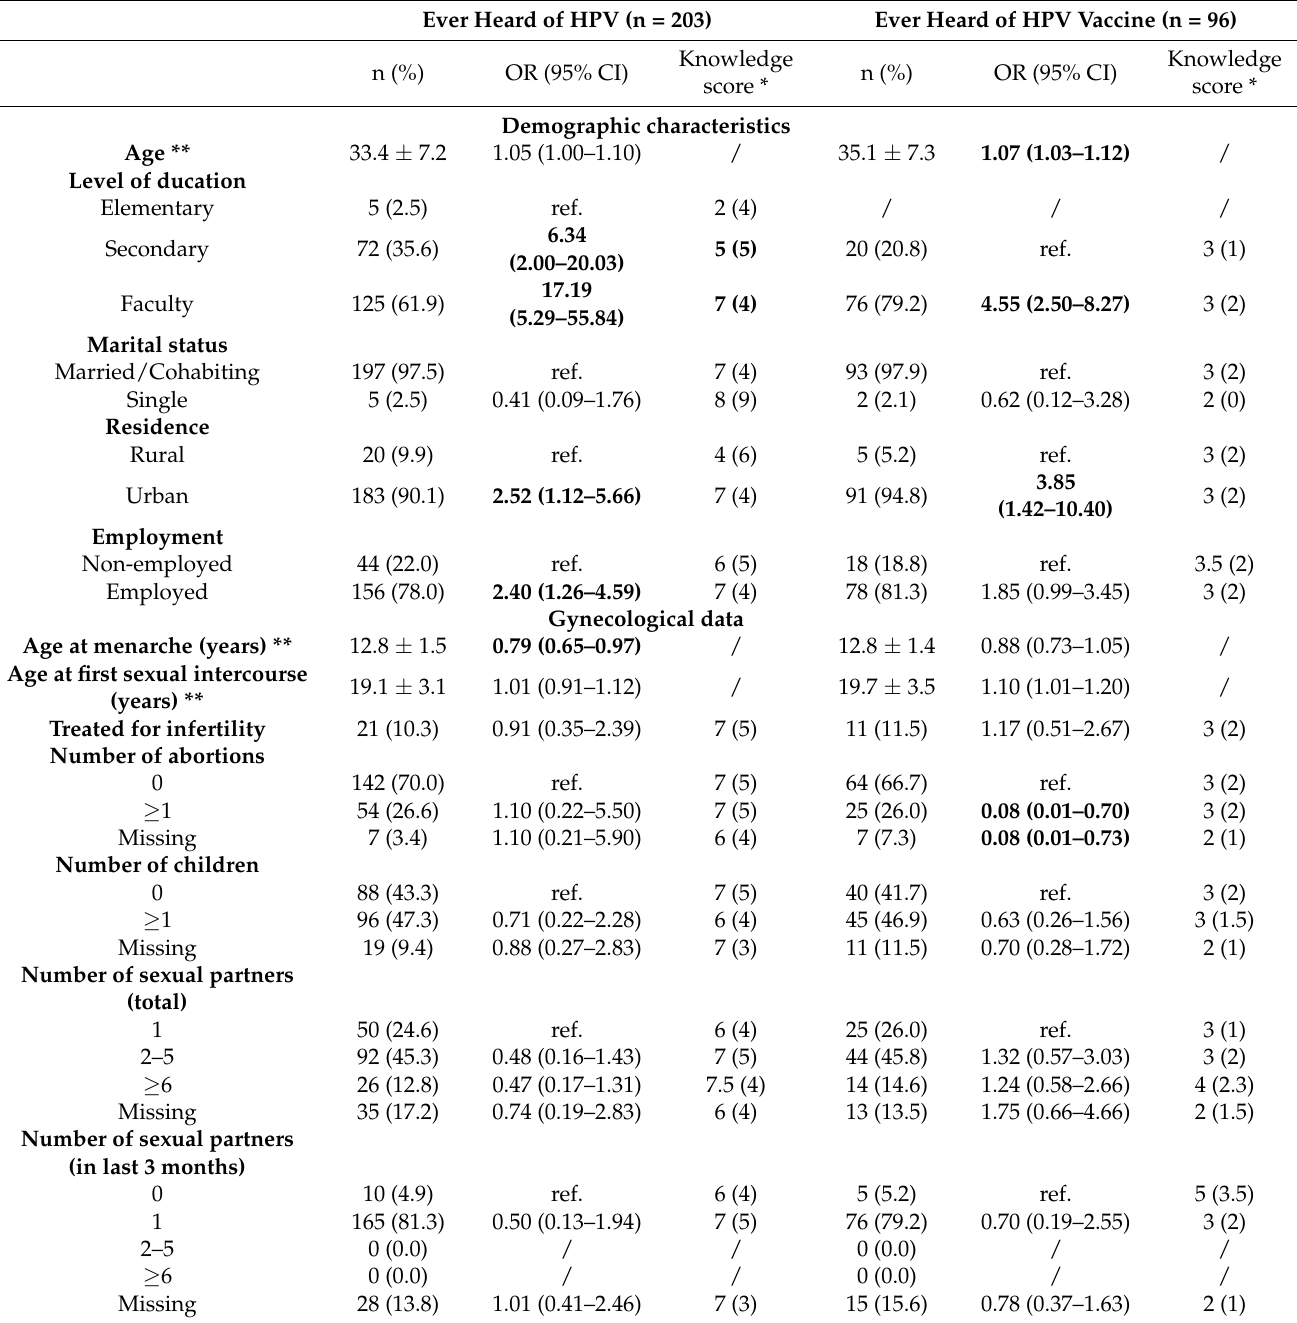
Table 2. Odds ratios and 95% CI for HPV and HPV vaccine awareness along with corresponding knowledge scores. Ever Heard of HPV (n =